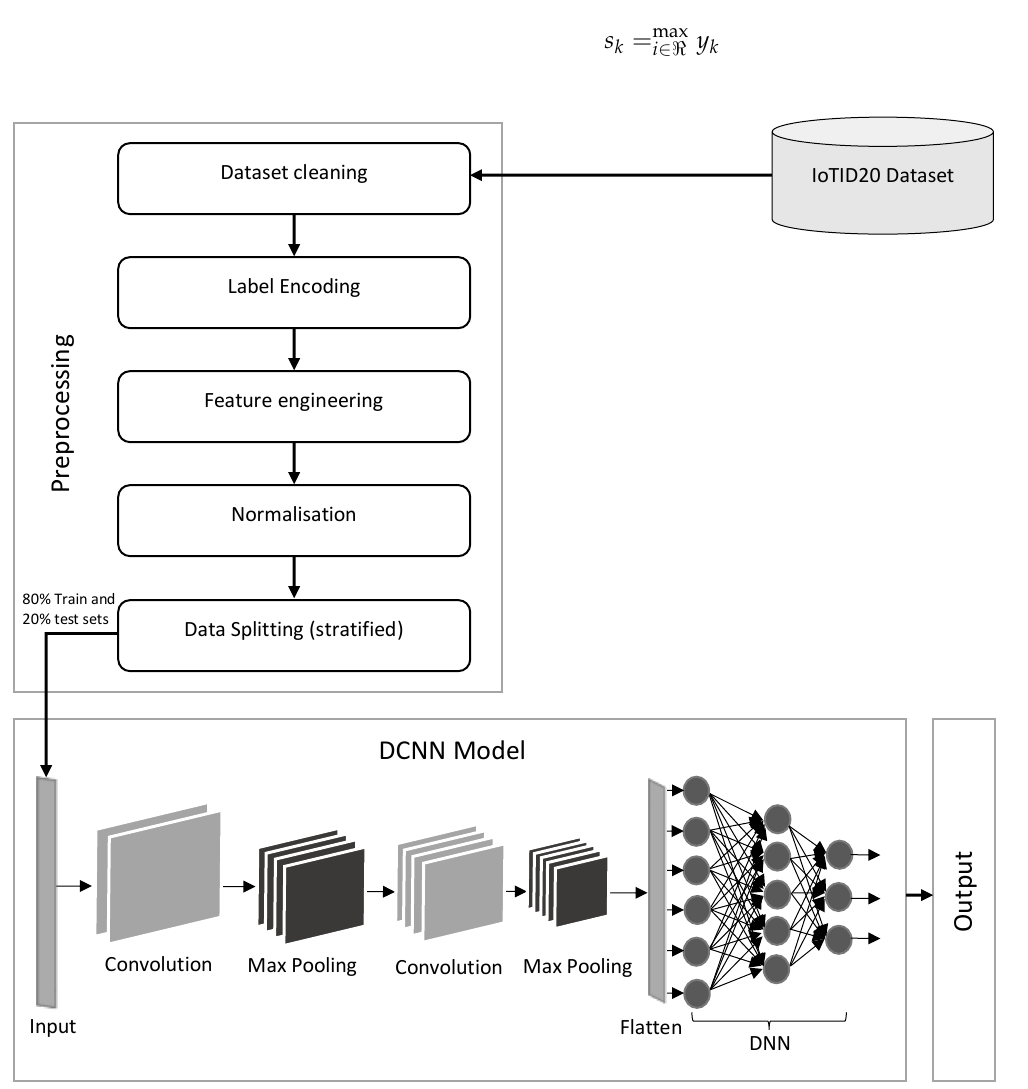
Figure 2. Architecture of the proposed DCNN